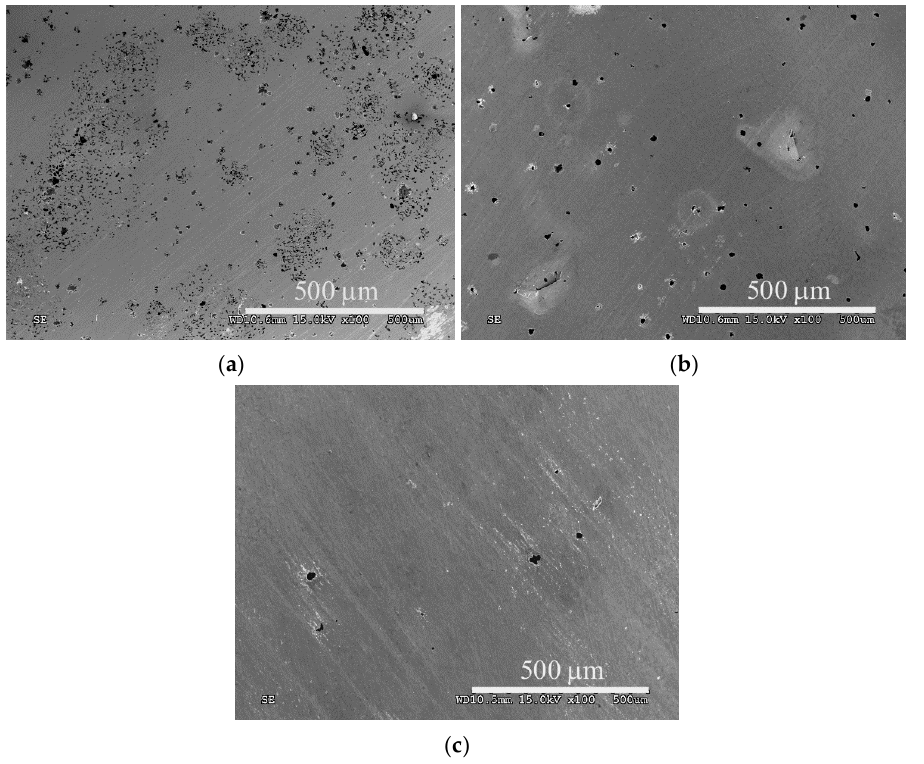
Figure 8. Images of the surface of AISI 316L steel in its initial state ( a ), following ASPN ( b ) and ASPNC ( c ) after potentiodynamic tests up to 2000